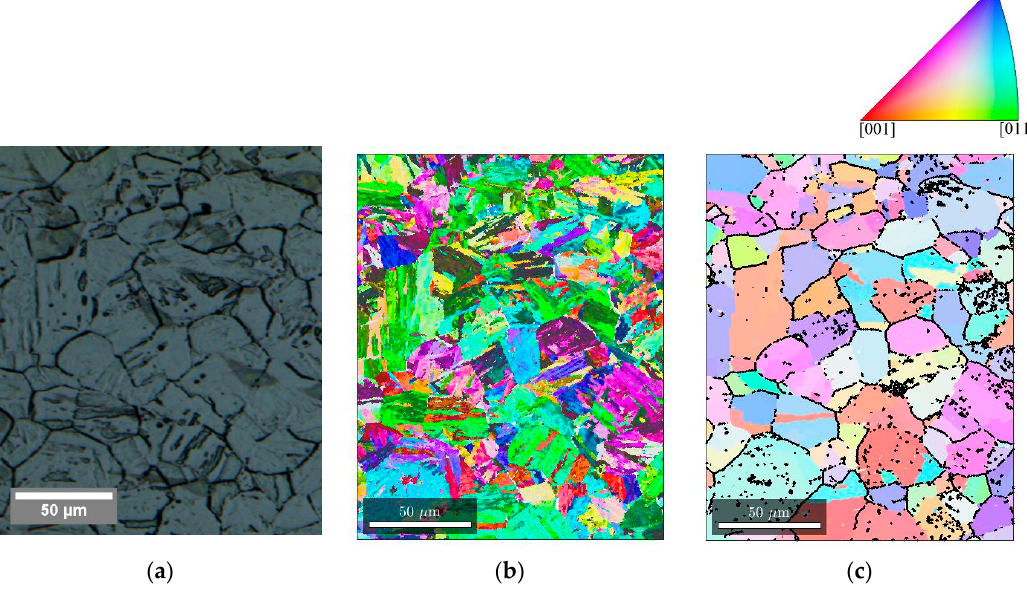
Figure 13. Comparison of the reconstructed PAGS maps to a picral etched micrograph. ( a ) Micrograph after picral etching; ( b ) EBSD OIM map from quenched specimen; ( c ) reconstructed OIM map of austenite, based on ( b ). High-Nb sample austenitized to 1150 °C for 1 h.